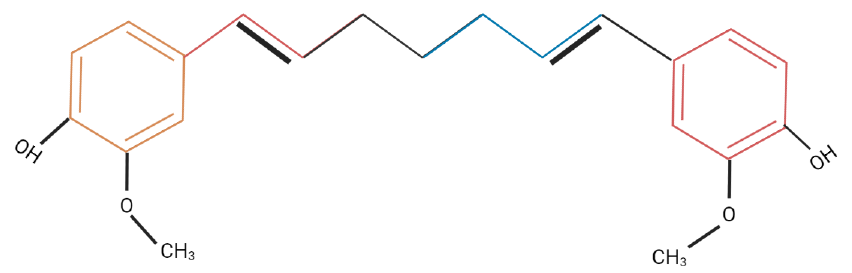
Figure 2. Chemical structure of